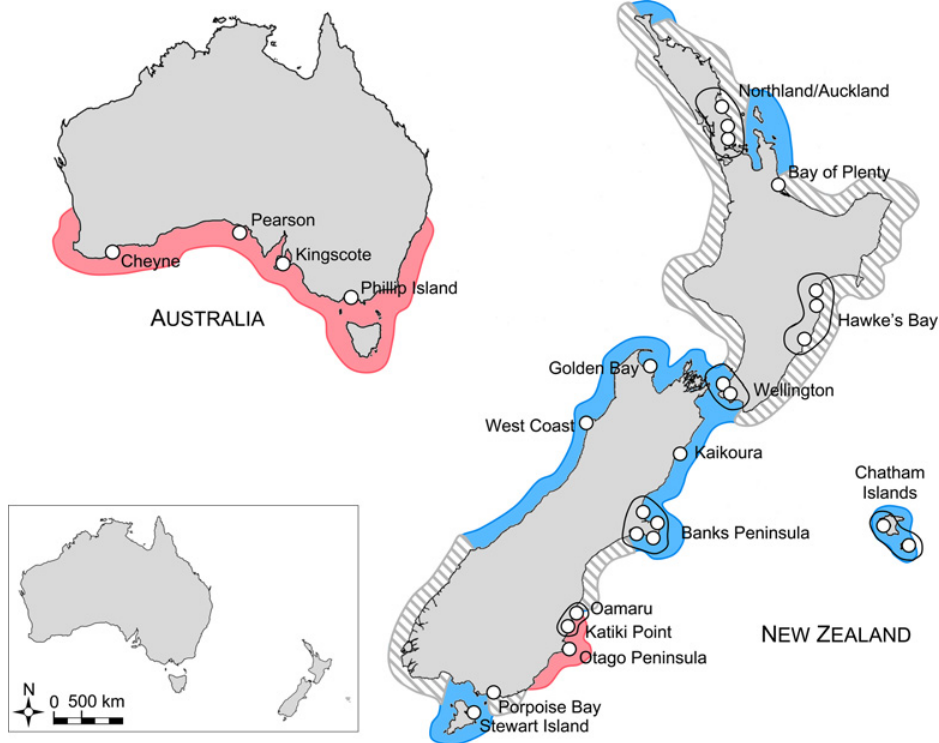
Fig 1. Map of distribution of Eudyptula penguins. Blue and red colours indicate previously-inferred ranges of New Zealand and Australian mitochondrial lineages [18,19], respectively. Lineage distributions in grey dashed areas are unknown. White circles mark sampling localities for the current study. Black lines indicate proximate samples pooled as a priori regional groupings to increase population sample size.